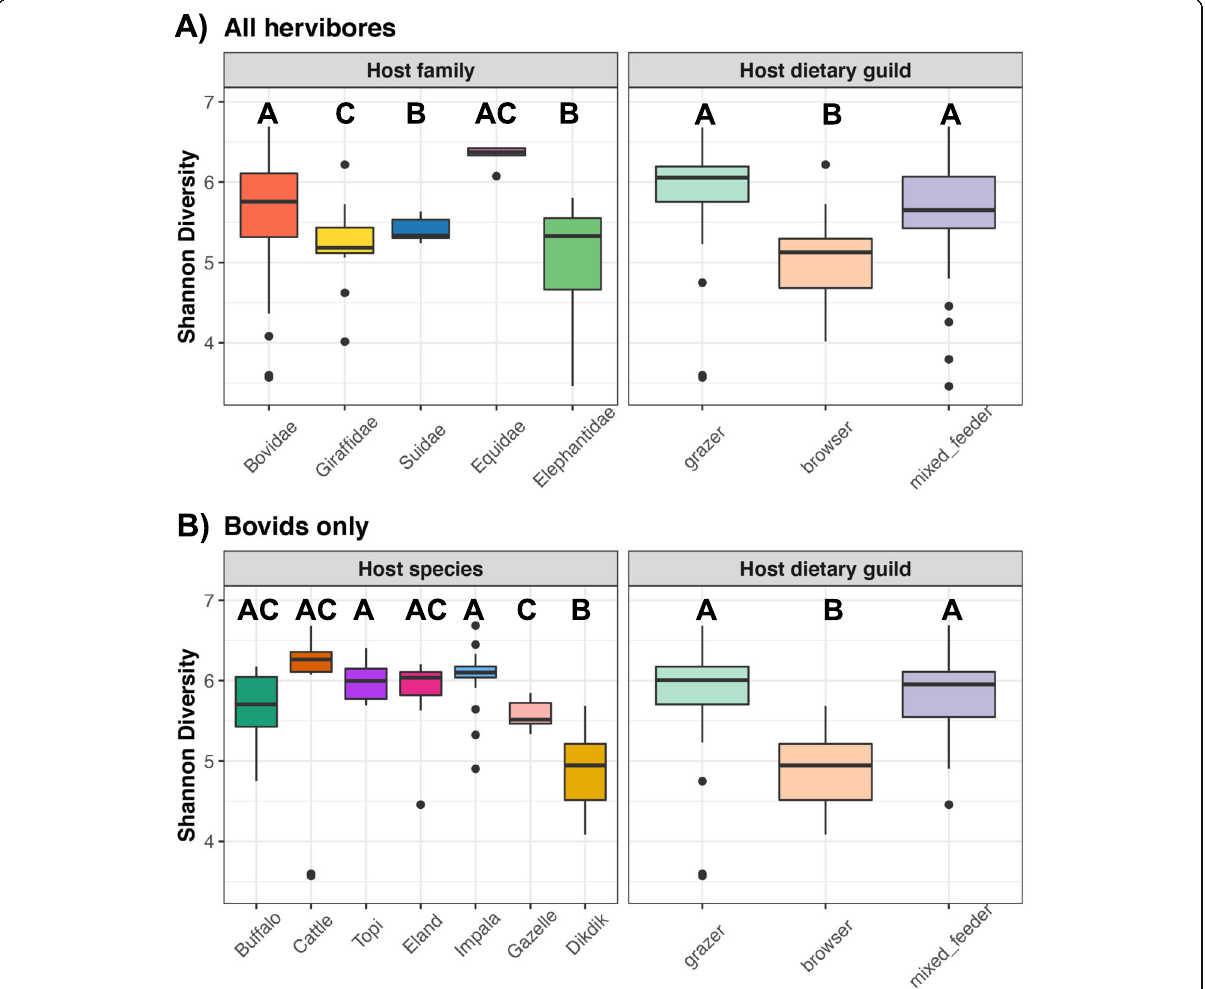
Fig. 3 Host taxonomy and dietary guild are associated with gut microbiota diversity in African herbivores. a Boxplots of microbiota evenness (Shannon diversity) among host families and dietary guilds across all studied herbivores, and b ) among host species and dietary guilds within the family Bovidae . Boxes that do not share any letters represent statistically significant comparisons; see Tables S3-S6 for all post-hoc comparisons. Thicker dots represent outlier